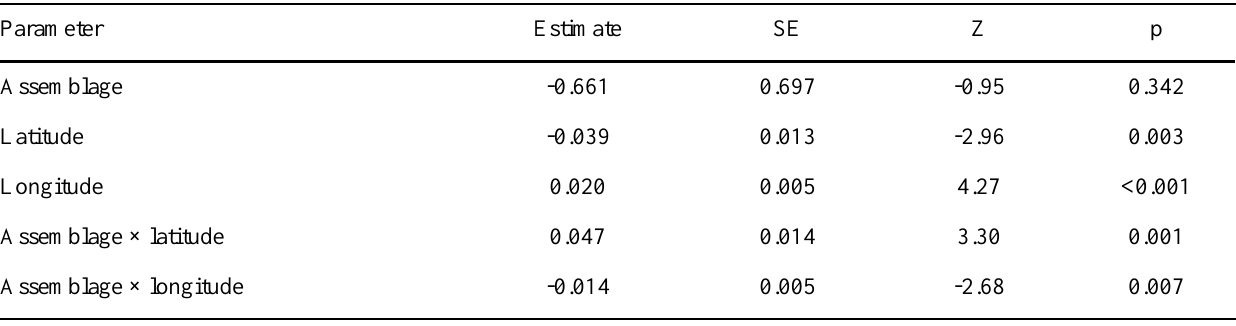
Table 2 .Parameter estimates from a general linear model (logit link, binomial errors) assessing whether population declines in aerial insectivorous passerines (24 species) differed from other passerines (186 species). The model assessed the effect of latitude, longitude, and assemblage (‘aerial insectivore’ or ‘other’) on the odds of species declining (number of species with trend < 0 vs. number of species with trend ‡ 0) within each of 58 North American jurisdictions (states and